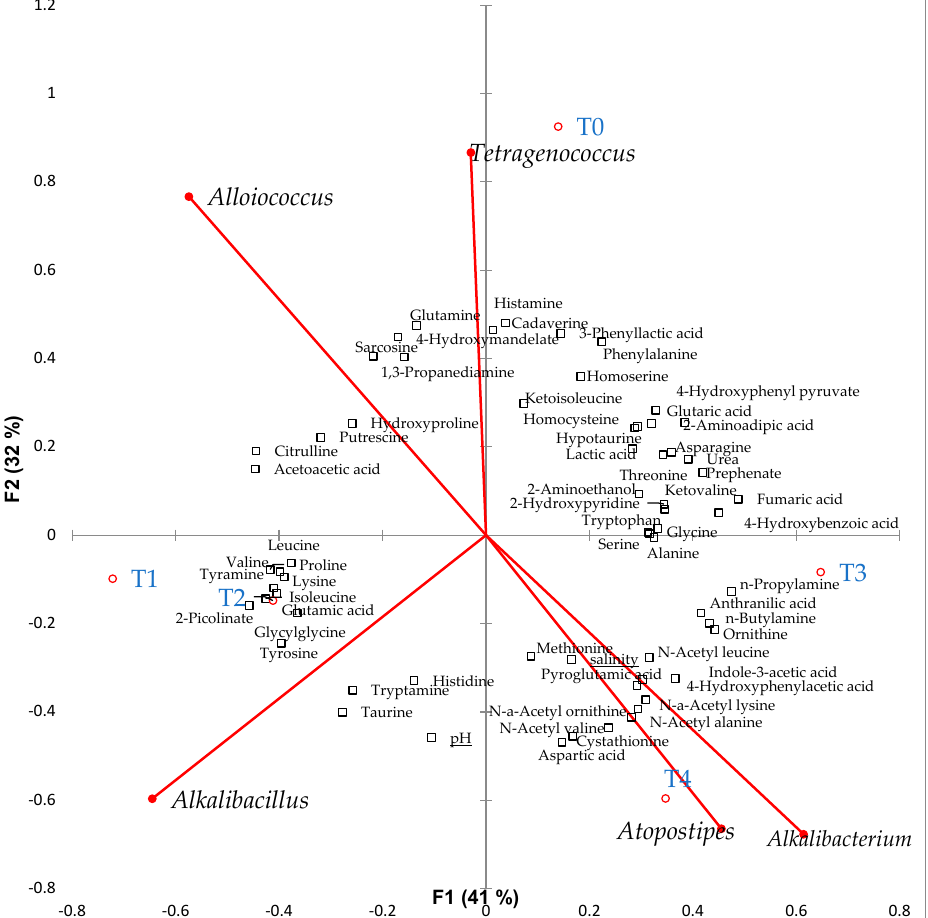
Figure 6. Redundancy analysis (RDA) showing the relationship between some metabolites (amino acids, amino acid’s degradation products, biogenic amines, and some putrefaction compounds) and dominant bacteria in low–salt shrimp paste during fermentation. Black square = metabolites, pH, and salinity; red dot = low–salt shrimp paste; red line = bacteria. RDA were analyzed using XL–STAT.